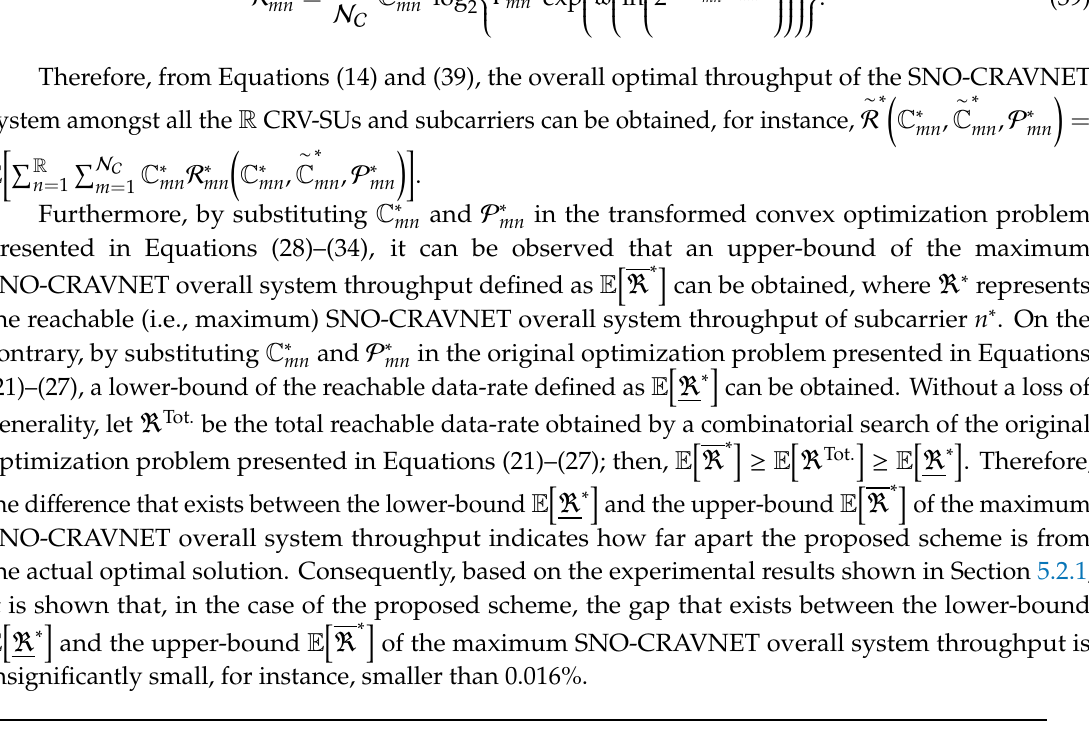
Algorithm 1 Pseudo-code to find the joint optimal transmit power and subcarrier allocation